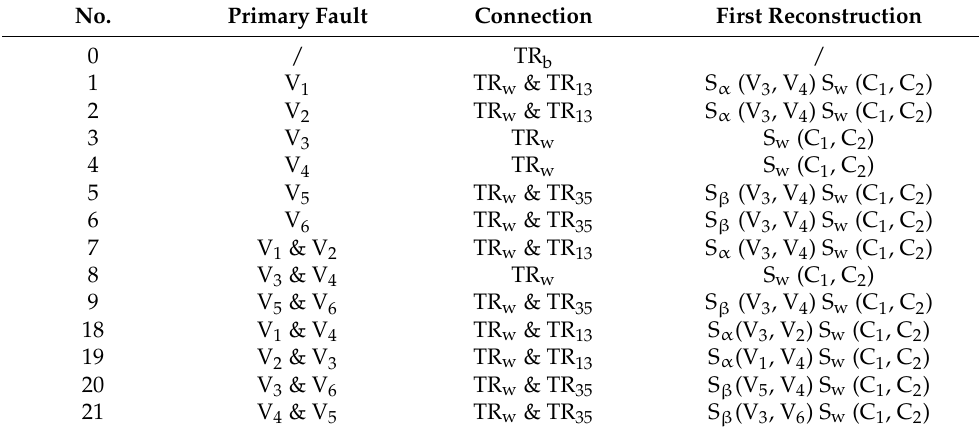
Table 2. First reconfigurable inverter switching